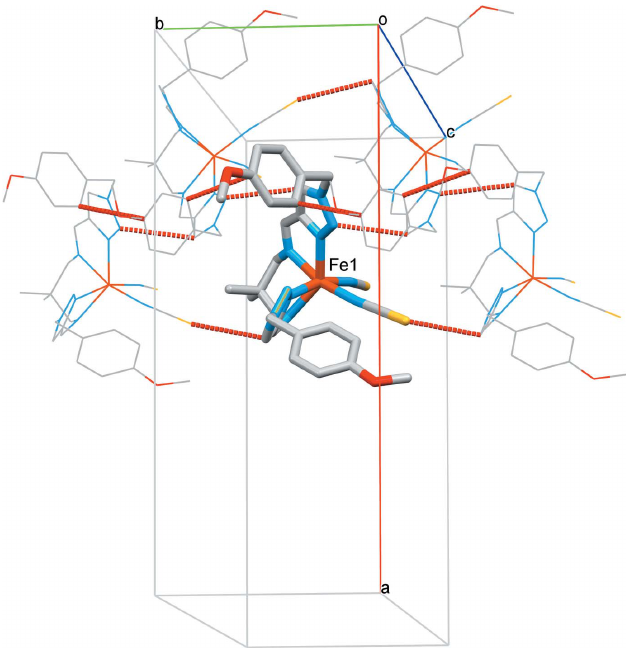
Figure 2 The packing of molecules into one-dimensional chains running parallel to [010] held together by weak C (cid:2)(cid:2)(cid:2) C/N/S bonding.